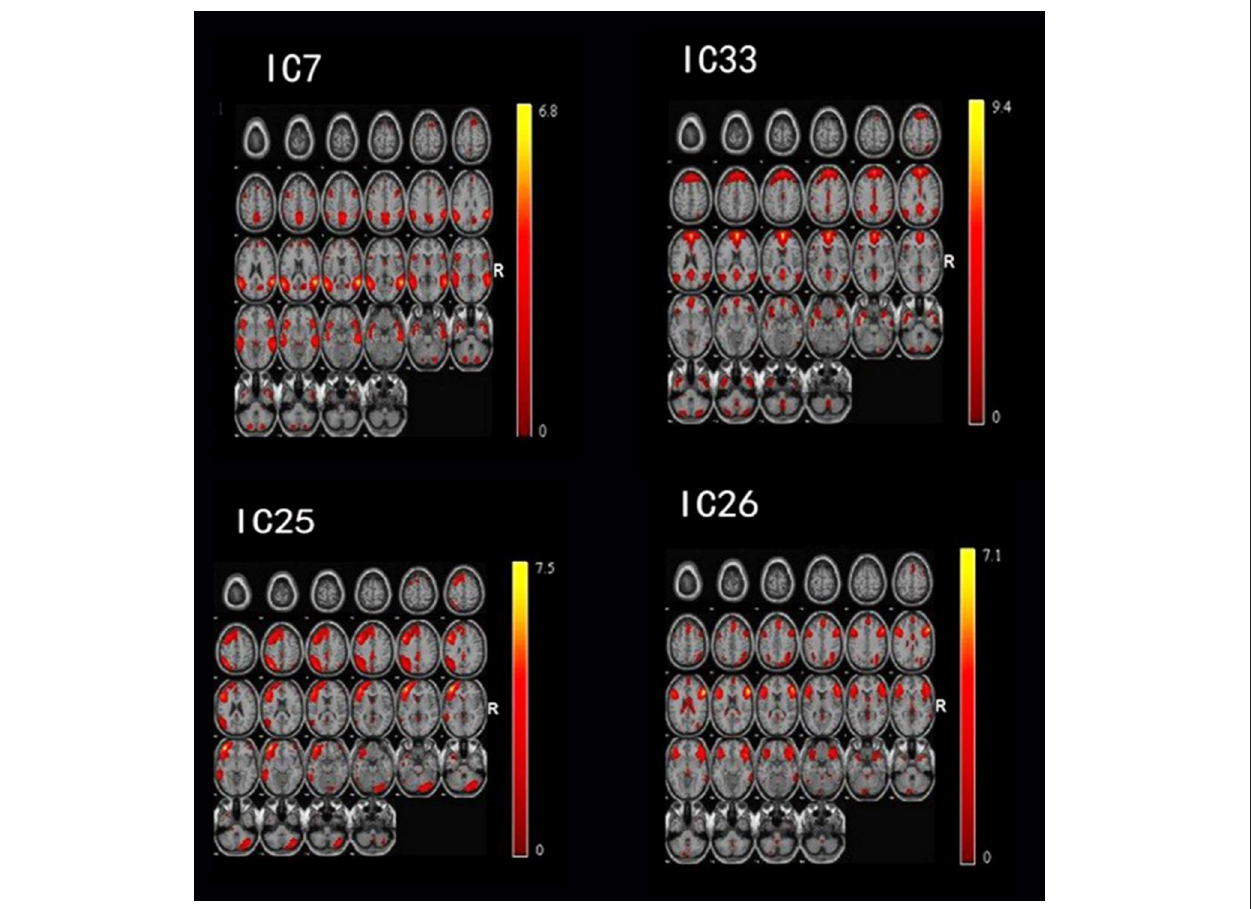
FIGURE 1 | By using the method of gICA, three intrinsic networks, including the default mode network (DMN) located at the IC7 and IC33, frontoparietal network (FPN) located at the IC25, and central executive network (CEN) located at the IC26, showed significant activity differences across healthy controls, bipolar depressive and bipolar manic